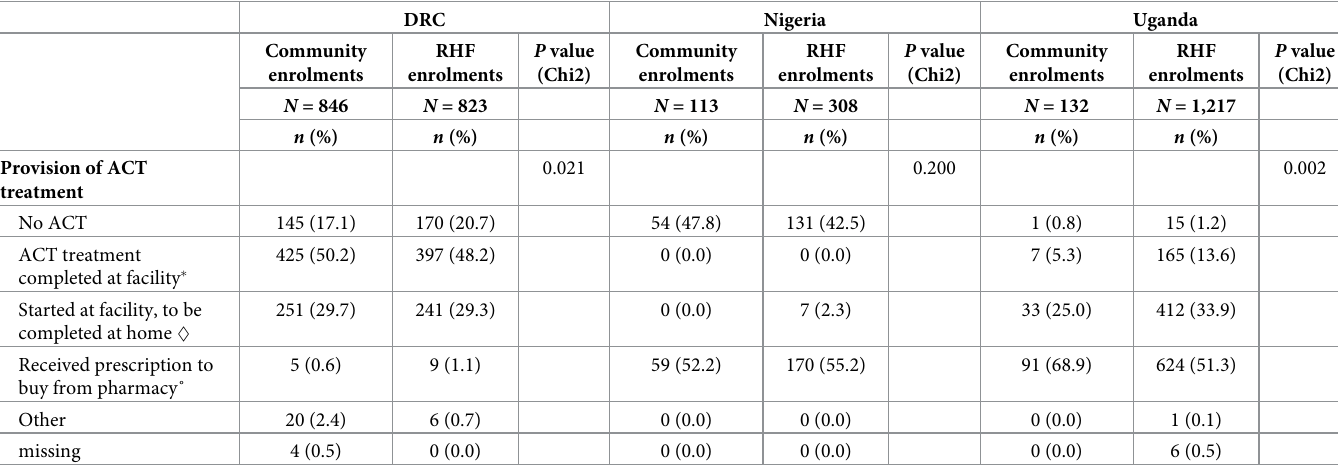
Table 4. Provision of in-hospital vs. post-discharge ACT